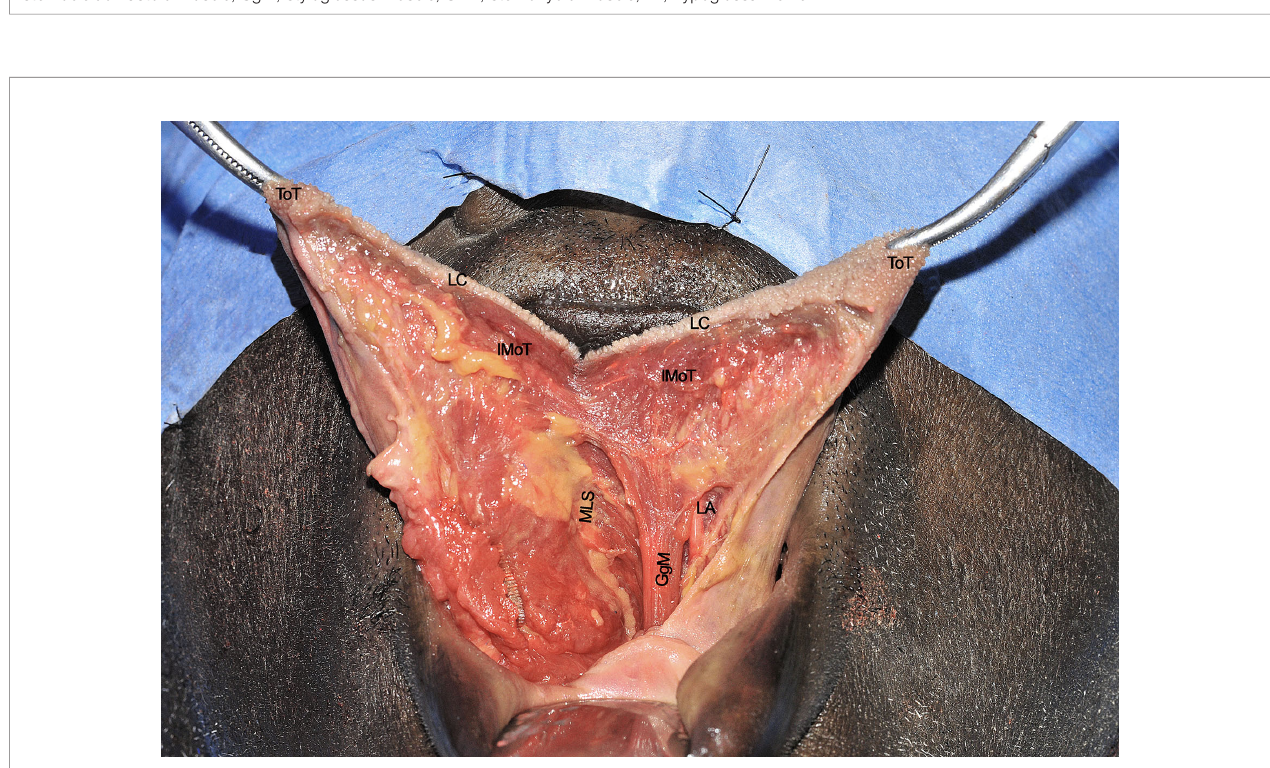
FIGURE 10 | GgM, genioglossus muscle; IMoT, intrinsic musculature of the tongue; LA, lingual artery; LC, lingual cover; MLS, median lingual septum; ToT, tip of tongue. Please note that the nose is covered by the blue drape and the inferior lip pulled down by a